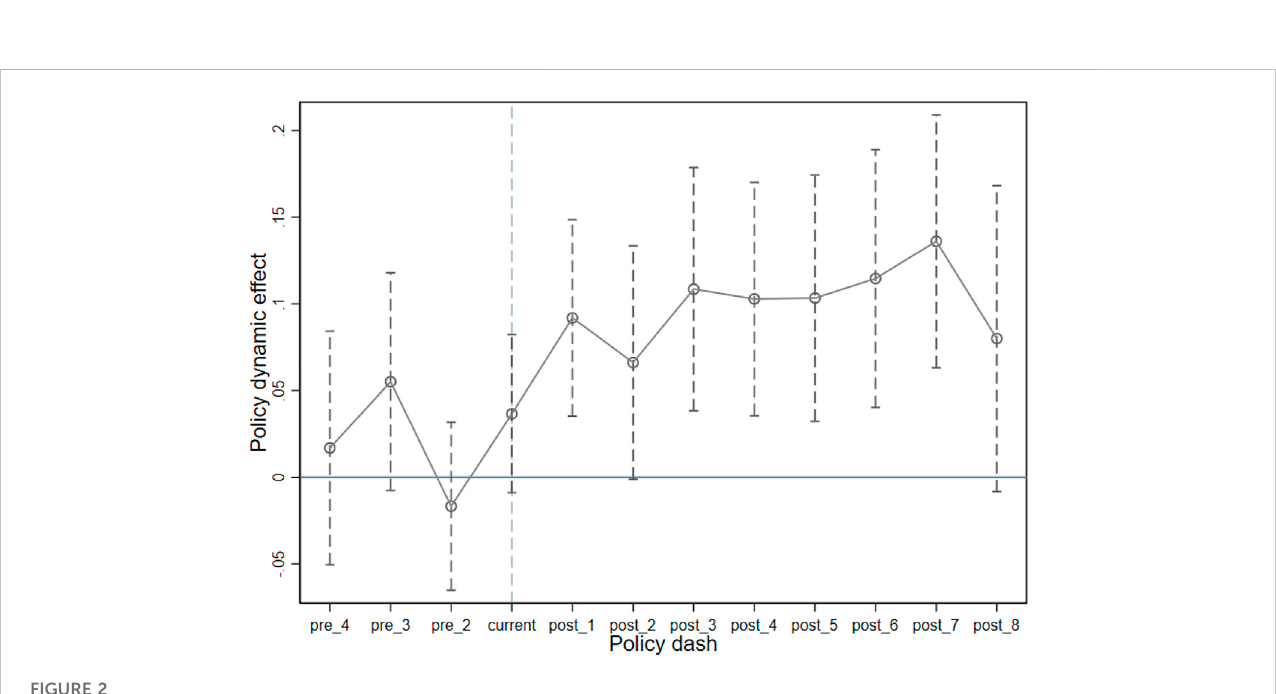
FIGURE 2 Parallel trend test from 2008 to